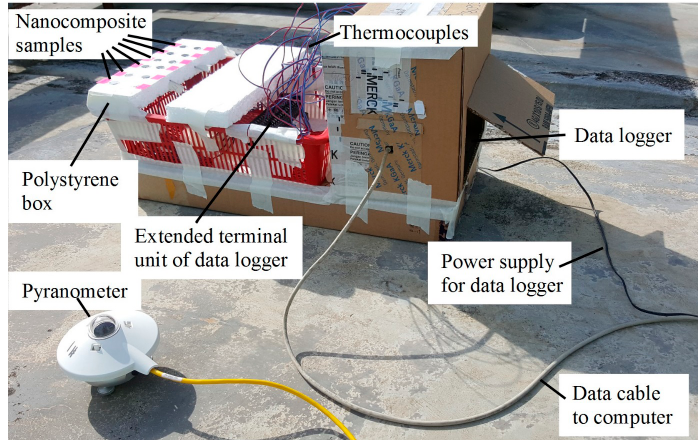
Figure 2. Outdoor experiment setup for solar energy conversion efficiency measurement.